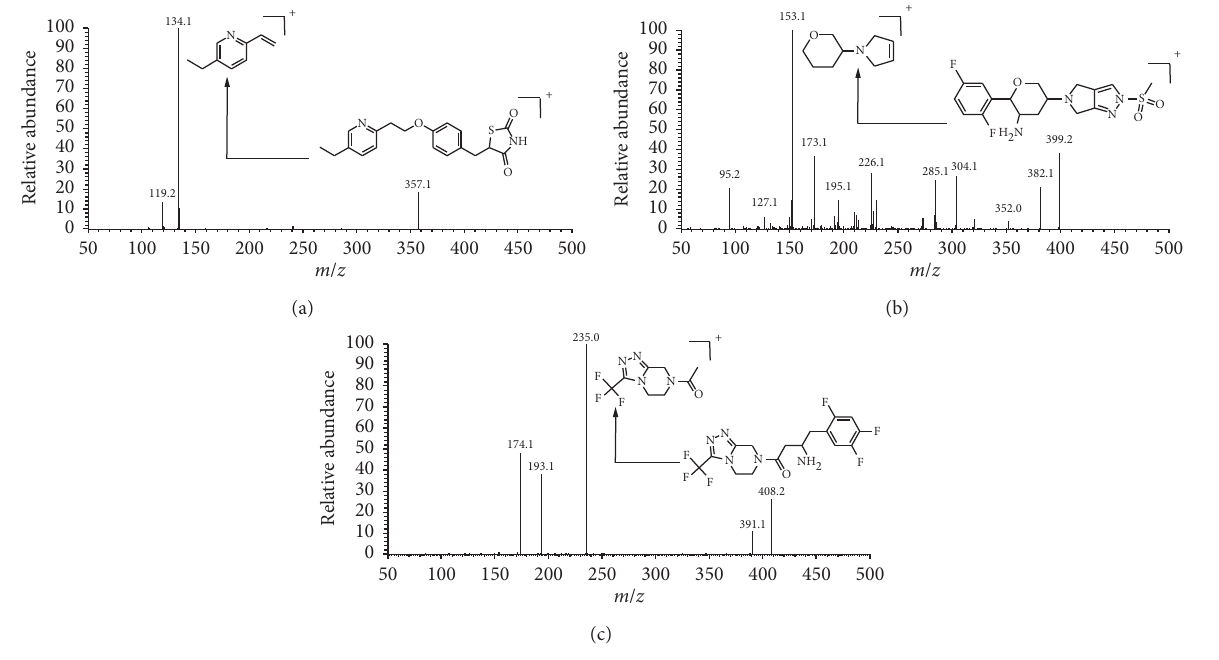
Figure 2: The product ion mass spectra of pioglitazone (a), omarigliptin (b), and sitagliptin (c).